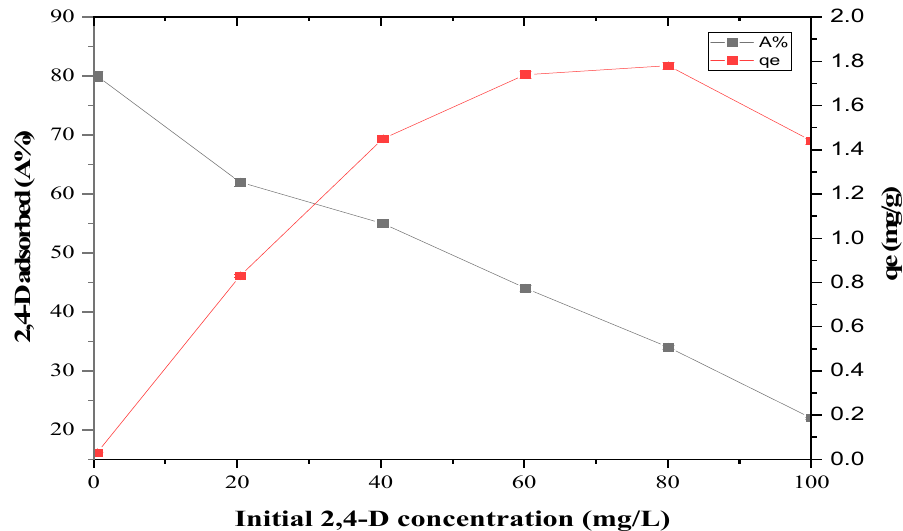
Figure 7. Effect of 2,4-D initial concentration on 2,4-D percentage removal (A%) and adsorption capacity (q e ). For three different sample runs, the error bars show the standard deviation.